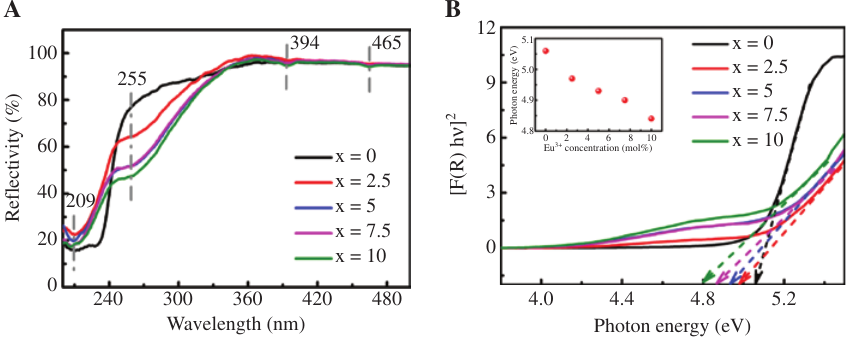
Figure 4: The analyses of UV-visible absorption property and optical bandgap. (A) Diffuse reflection spectra and (B) Tauc plots for ZrO energy with Eu 3 +